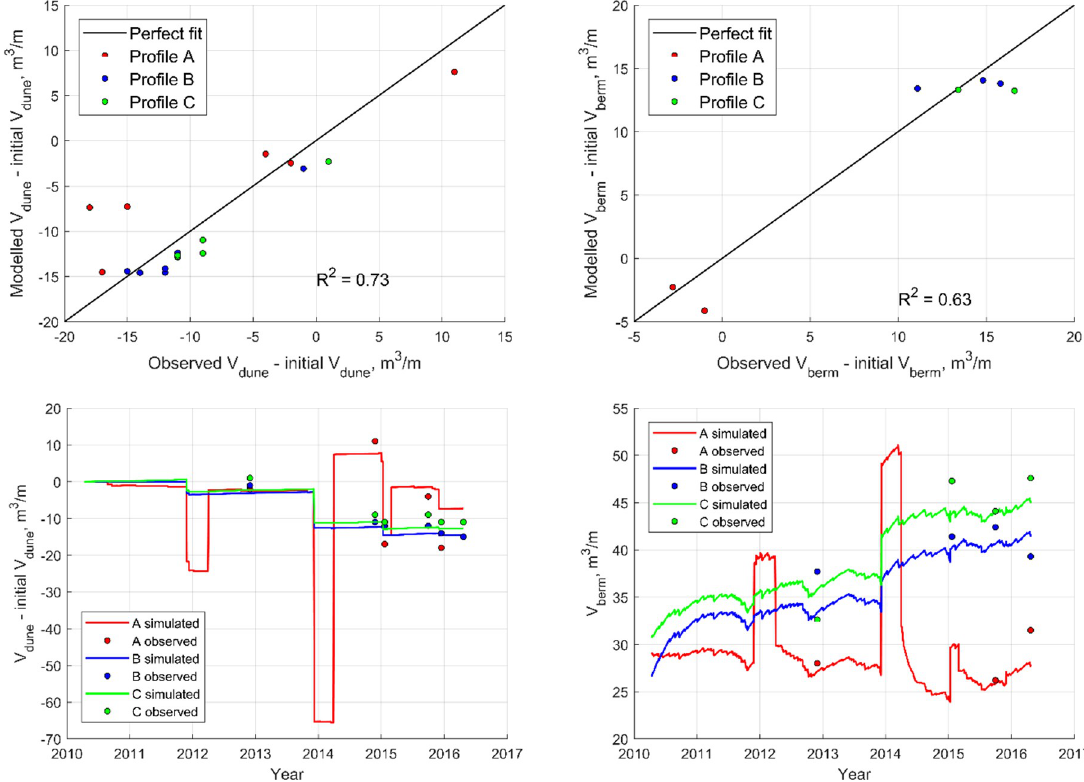
Fig 13. Dune and beach volume evolution for calibration